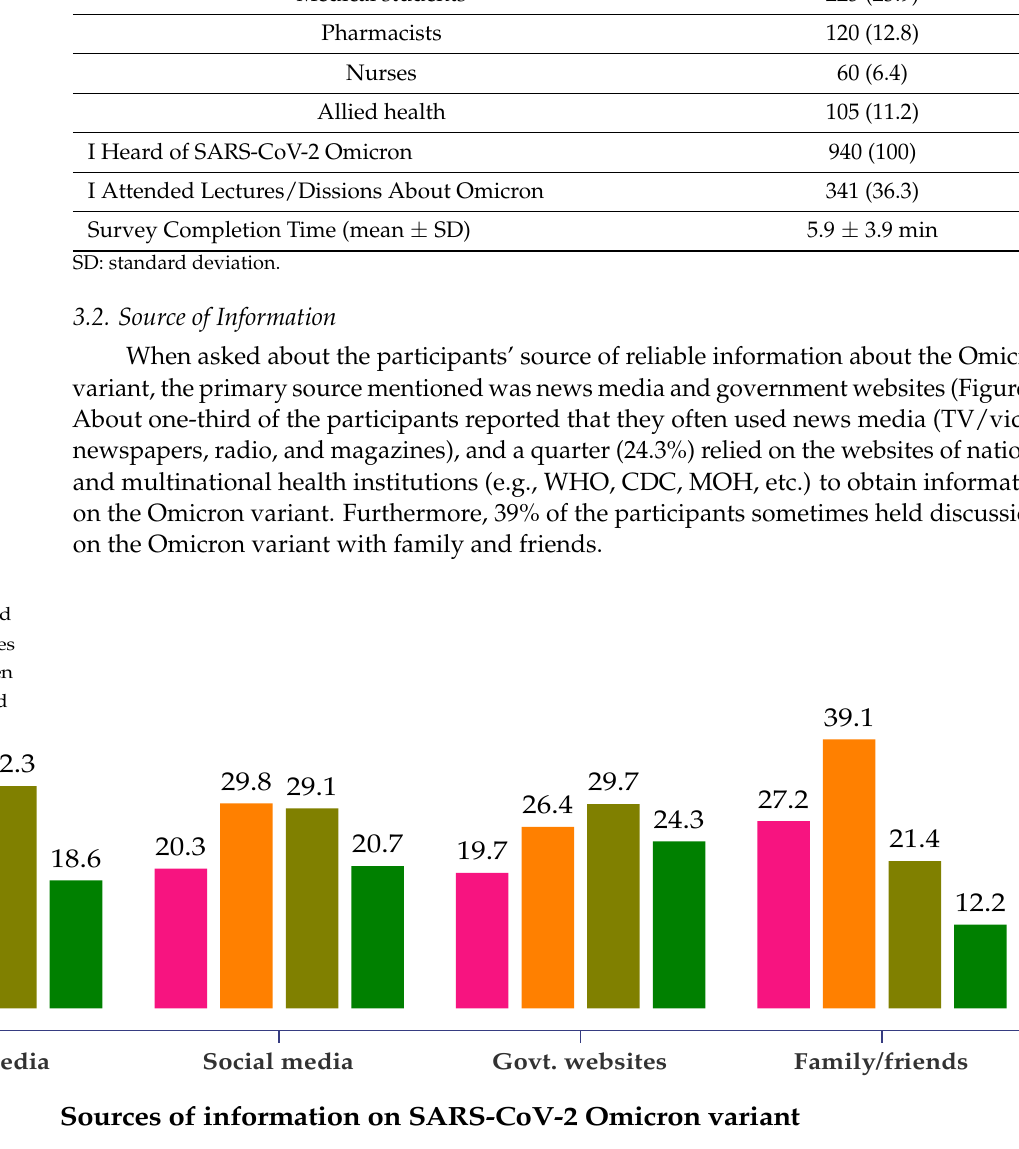
Figure 1. Healthcare workers’ sources of reliable information on the SARS-CoV-2 Omicron vari- ant.